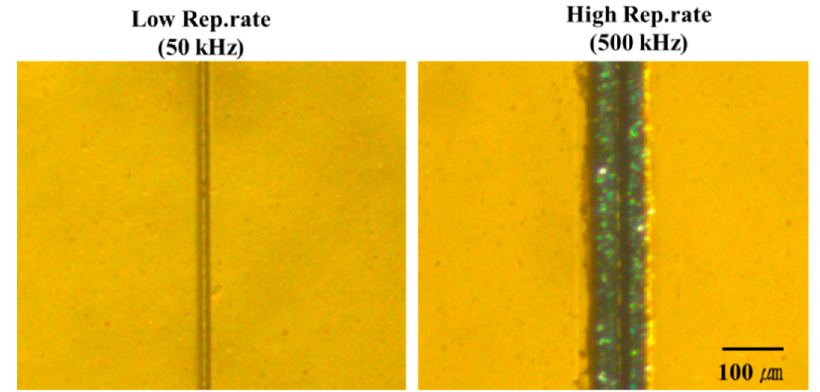
Figure 8. Reflective optical microscopy images of polyimide (PI) samples processed by low and high pulse repetition rates (at 7 mm/s).